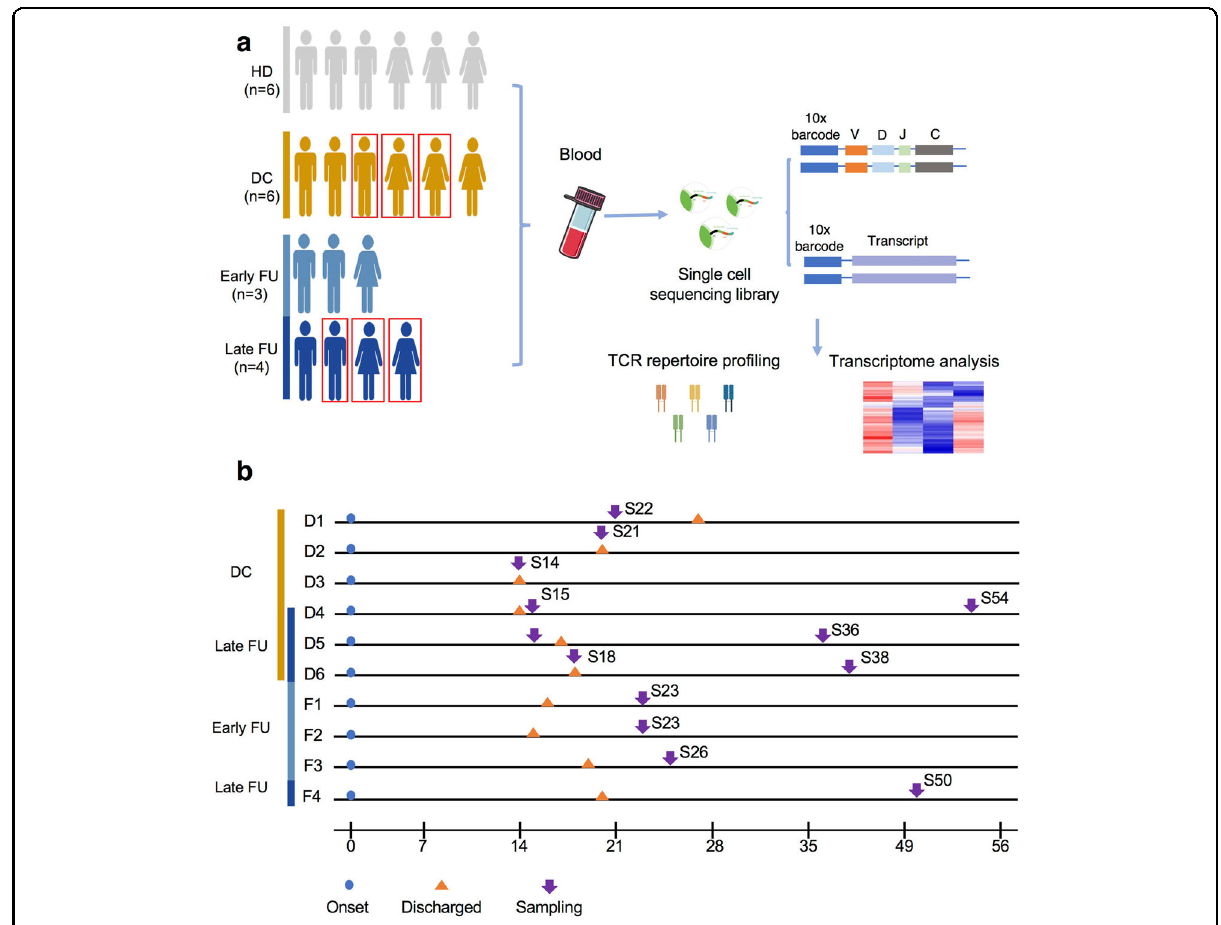
Fig. 1 Study work fl ow. a A schematic work fl ow of study design. PBMCs were collected and separated from four groups: Discharged (DC), Early Follow-up (Early FU), Late Follow-up (Late FU), and Healthy Donor (HD). The Early FU and Late FU were divided from Follow-up group. PBMCs were applied for scRNA and scTCR sequencing using 10X-Based Genomics platform. The red box indicated the same patients at different stages in our study. b Timeline of the disease course for 10 patients infected with SARS-CoV-2. The color bars on the left represent groups with the same color as in ( a ). DC, Discharged group; FU, Follow-up group; HD, Healthy Donor